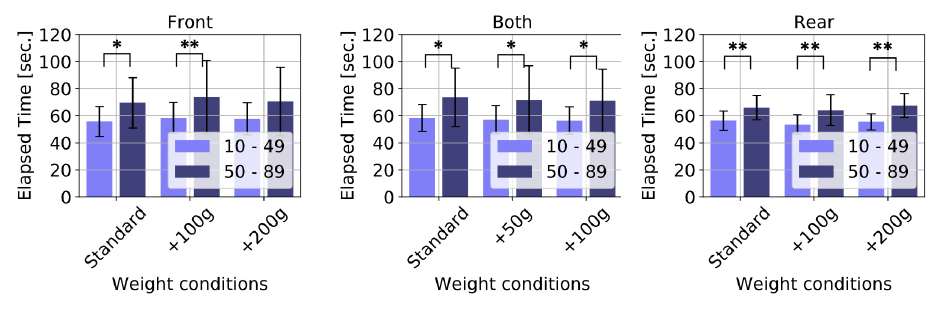
Figure 2. Game completion time for male participants. (*: p < 0.05, **: p < 0.01).